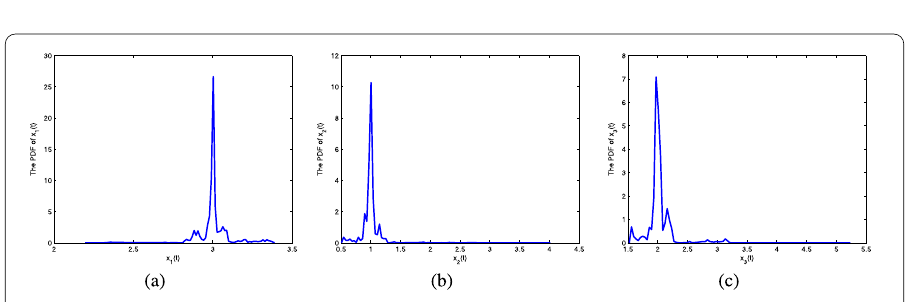
Figure 4 The probability density functions(PDFs) of three-species densities . (a) The probability density function (PDF) of x 1 ( t ) in Example 5.3; (b) The probability density function (PDF) of x 2 ( t ) in Example 5.3; (c) The probability density function (PDF) of x 3 ( t ) in Example